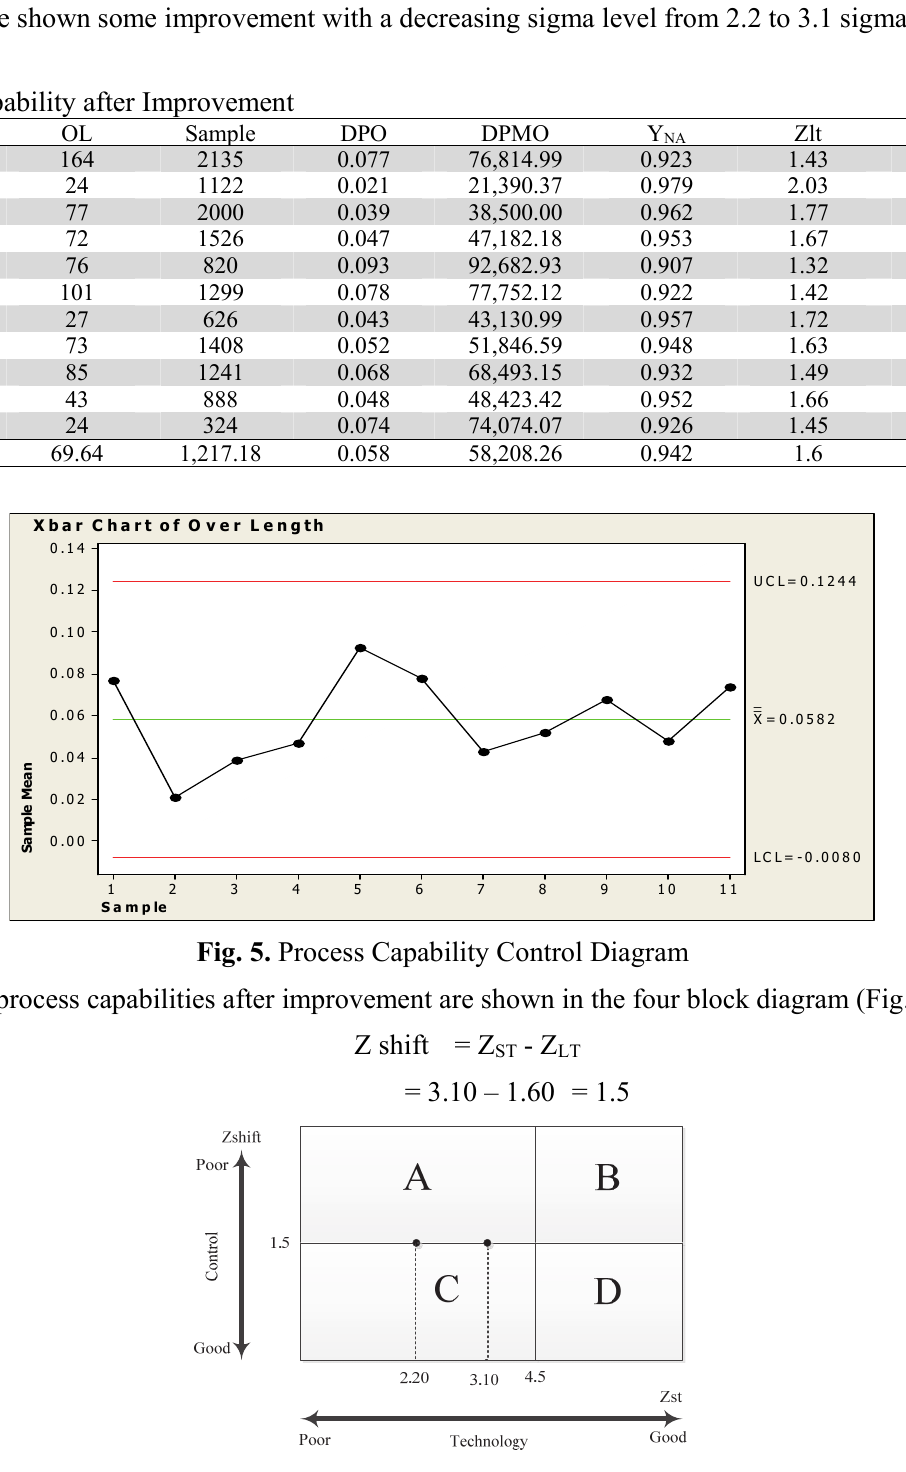
Fig. 6. Position of Process Capabilities after